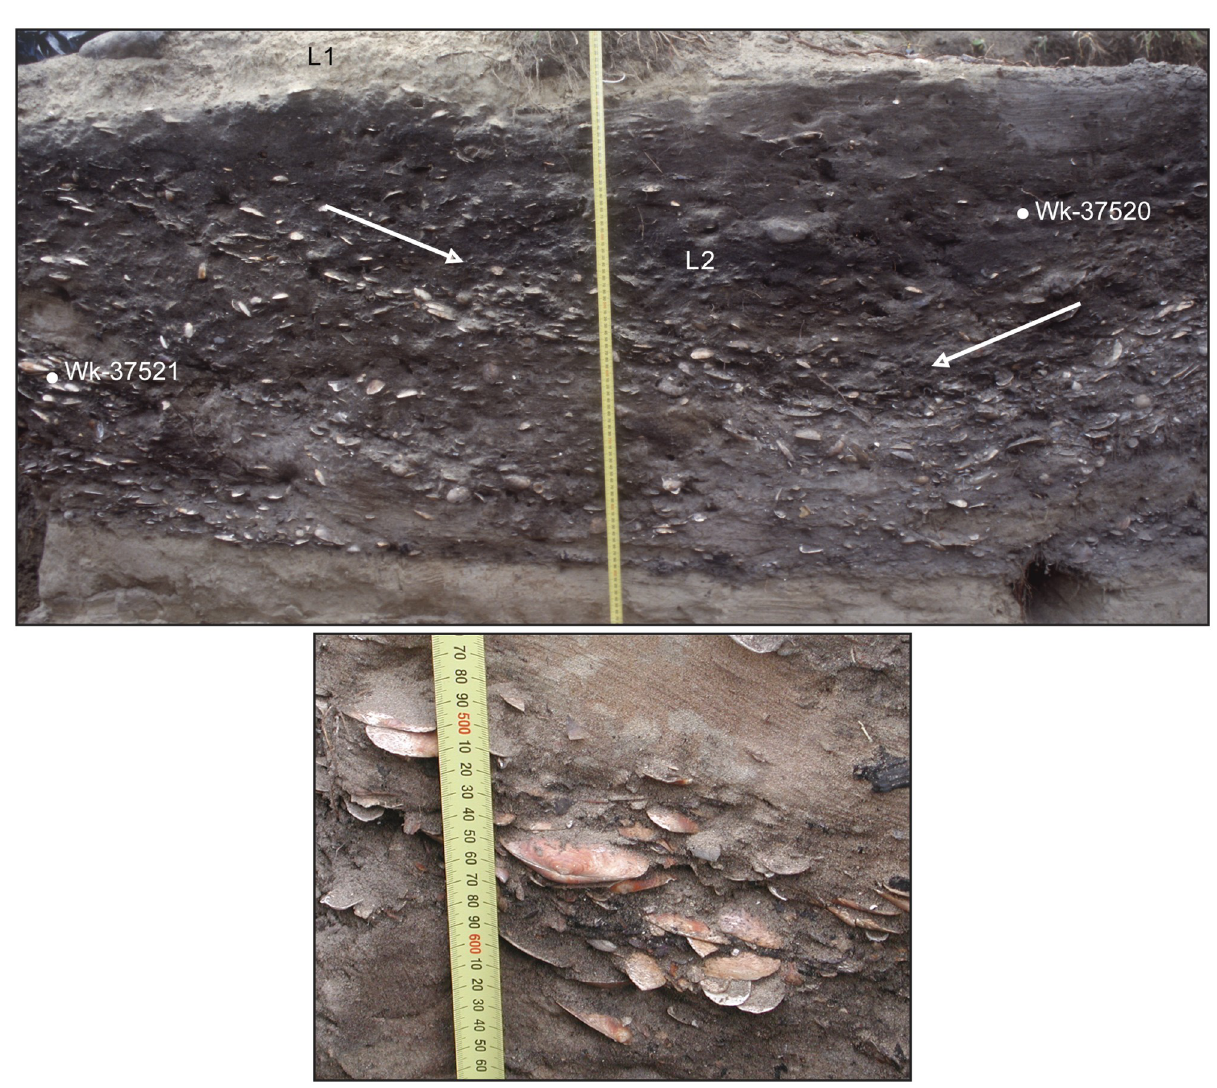
Fig 4. Images of P3 excavation section, I44/21 S. (Upper.) Main image, full section referenced from Fig 2, east face, perpendicular view. The locations of two dated marine samples ( Paphies australis ) are identified by 14 C Lab numbers. Arrows indicate mollusc valve orientation in fill lenses (tape scale 10 mm increments). (Lower.) Detail of closed, articulated P . australis bivalve dated as Wk-37521 (right of tape scale at 550 mm increment), oblique